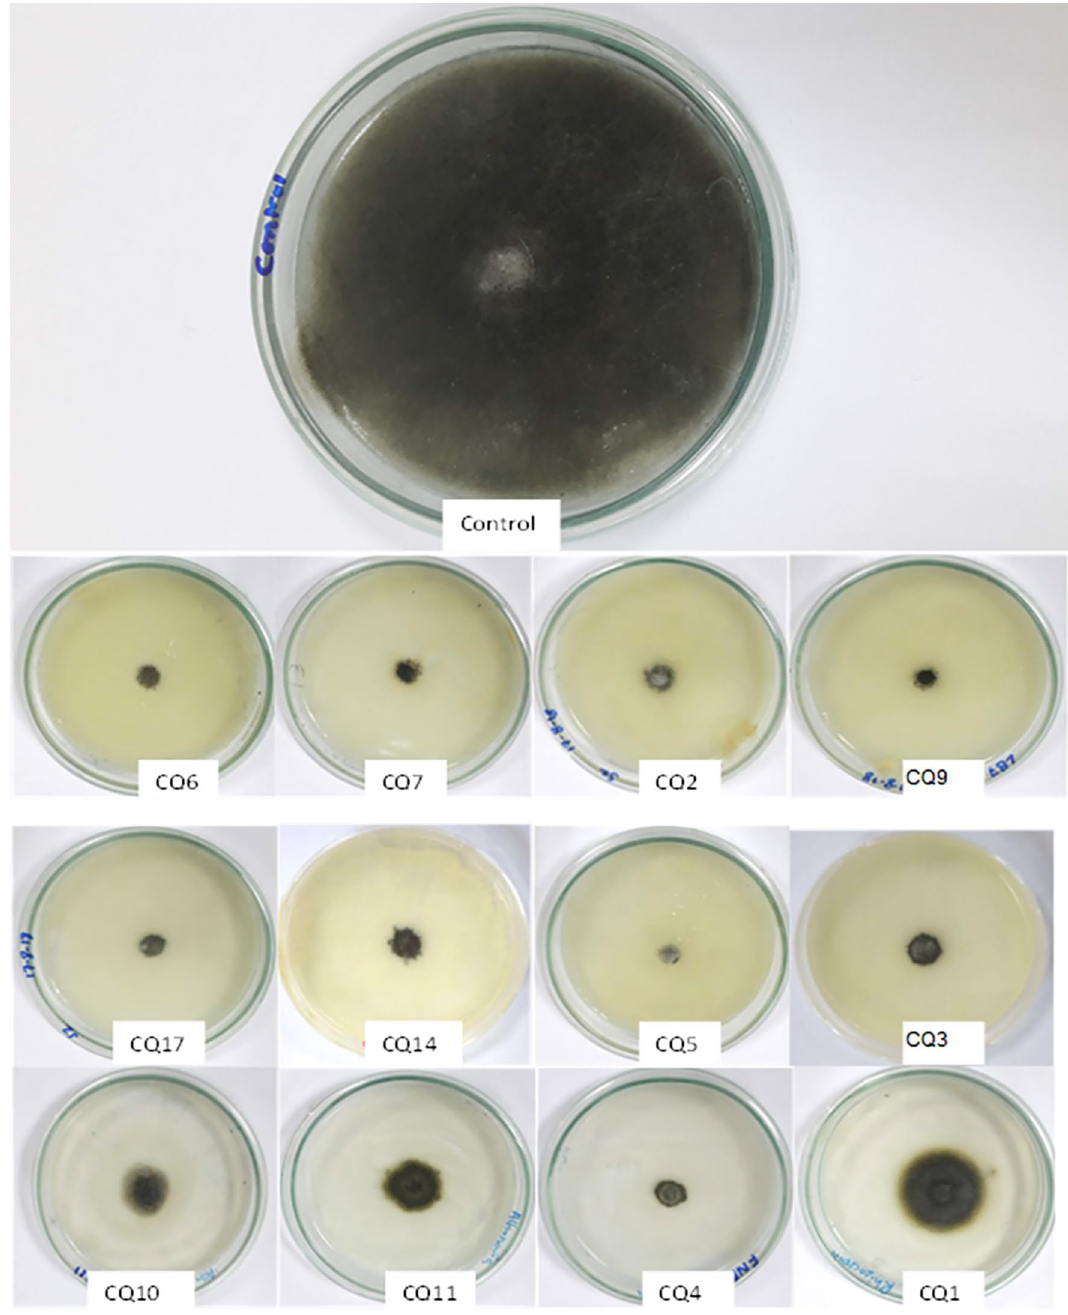
Figure 1. Antagonistic potential of selected bacterial strains against Alternaria alternata . Bacterial strains isolated from the rhizosphere of C. quinoa were subjected to antagonistic plate assay against A. alternata . The strains shown in this picture displayed maximum inhibition potential in addition to growth promoting activity and production of extracellular enzyme production, nutrient solubilization and siderophore production.After identification these strains were checked in pot experiment of tomato plants against A. alternata